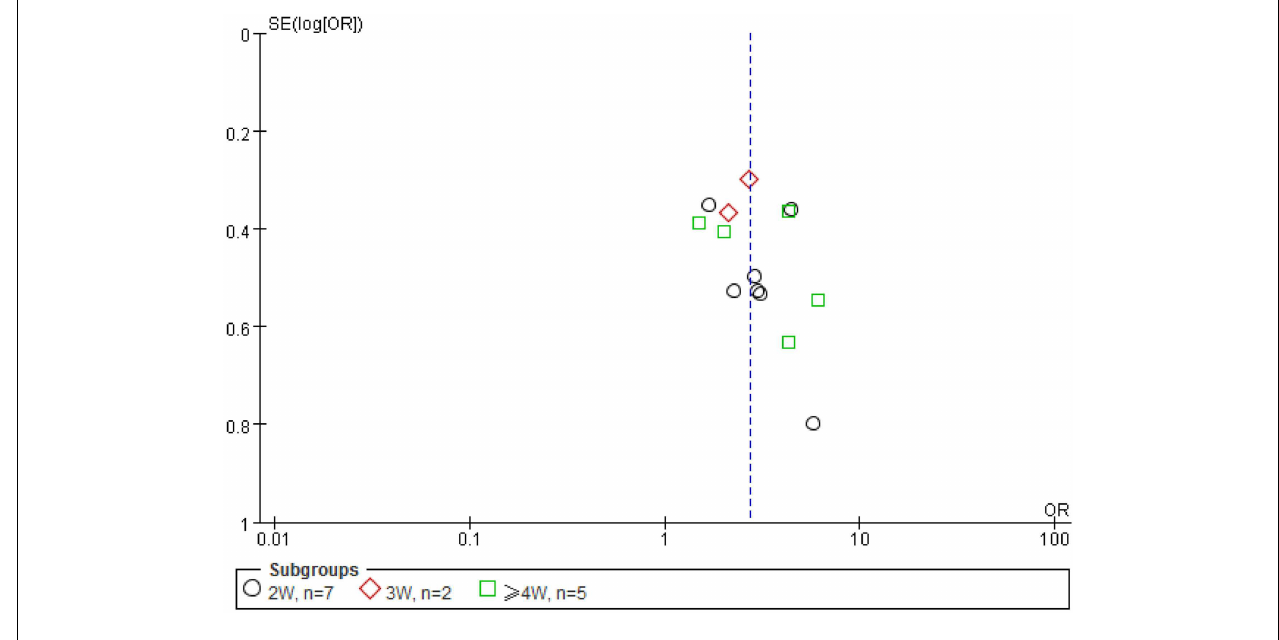
the ER at the end of 3weeks, and (3) 5 trials assessed the ER at the end of 4weeks. Because of the small number of trials involved, the imperfect or asymmetrical funnel plot is not a reliable indication of potential publication bias in this